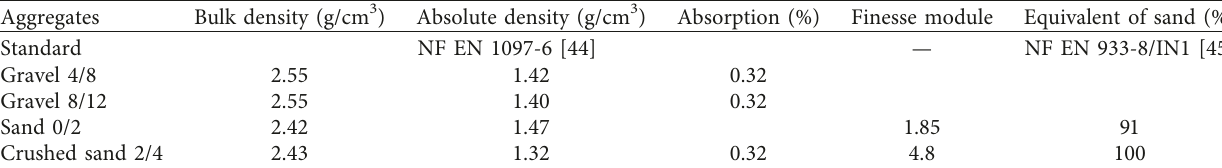
Table 5: Physical characteristics of